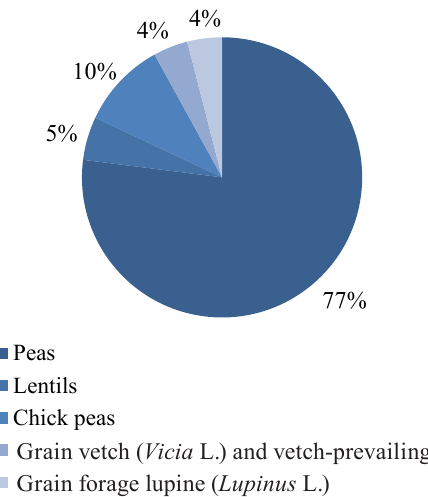
Figure 3 Percentage ratio of the croppage of legumes in Russia